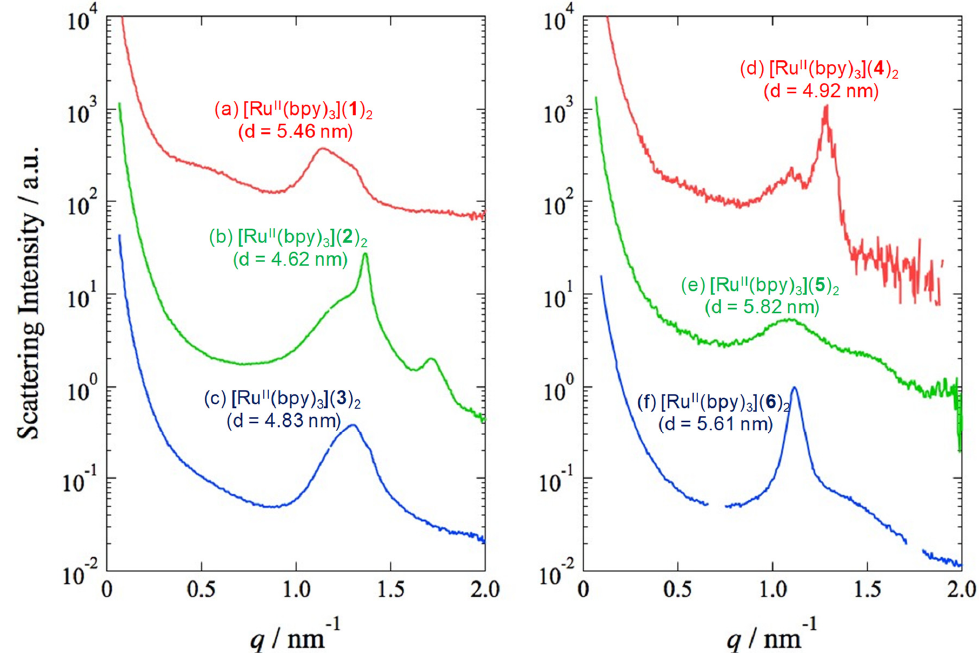
Figure 5. Wide-angle X-ray scattering (WAXS) patterns of [Ru II (bpy) 3 ](lipid) 2 in EtOH. Lipid = 1 ( a ), 2 ( b ), 3 ( c ), 4 ( d ), 5 ( e ), 6 (f).